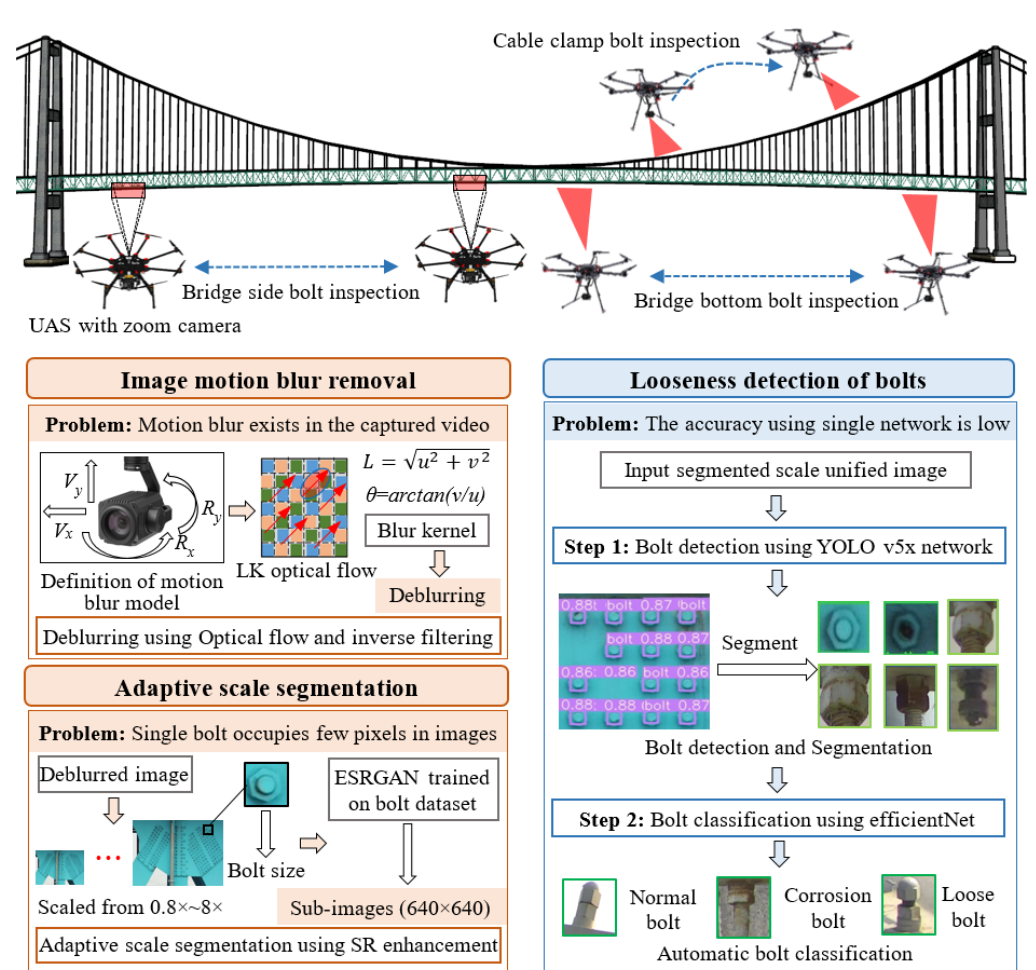
Figure 1. The framework of the proposed method.